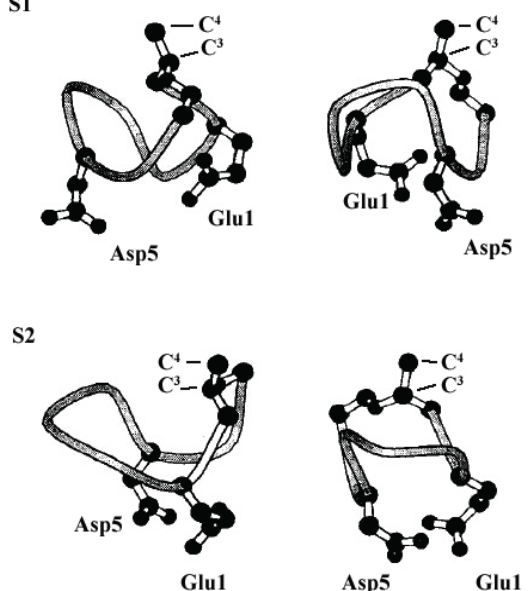
Figure 5. The S1 ( top ) and S2 ( bottom ) structure (only Glu 1 and Asp 5 residues have been represented, S1 and S2 exhibit a particular horse saddle folding mode (left) and acidic residues show a claw topology). Reprinted with permission from Bonmatin et al. [45].